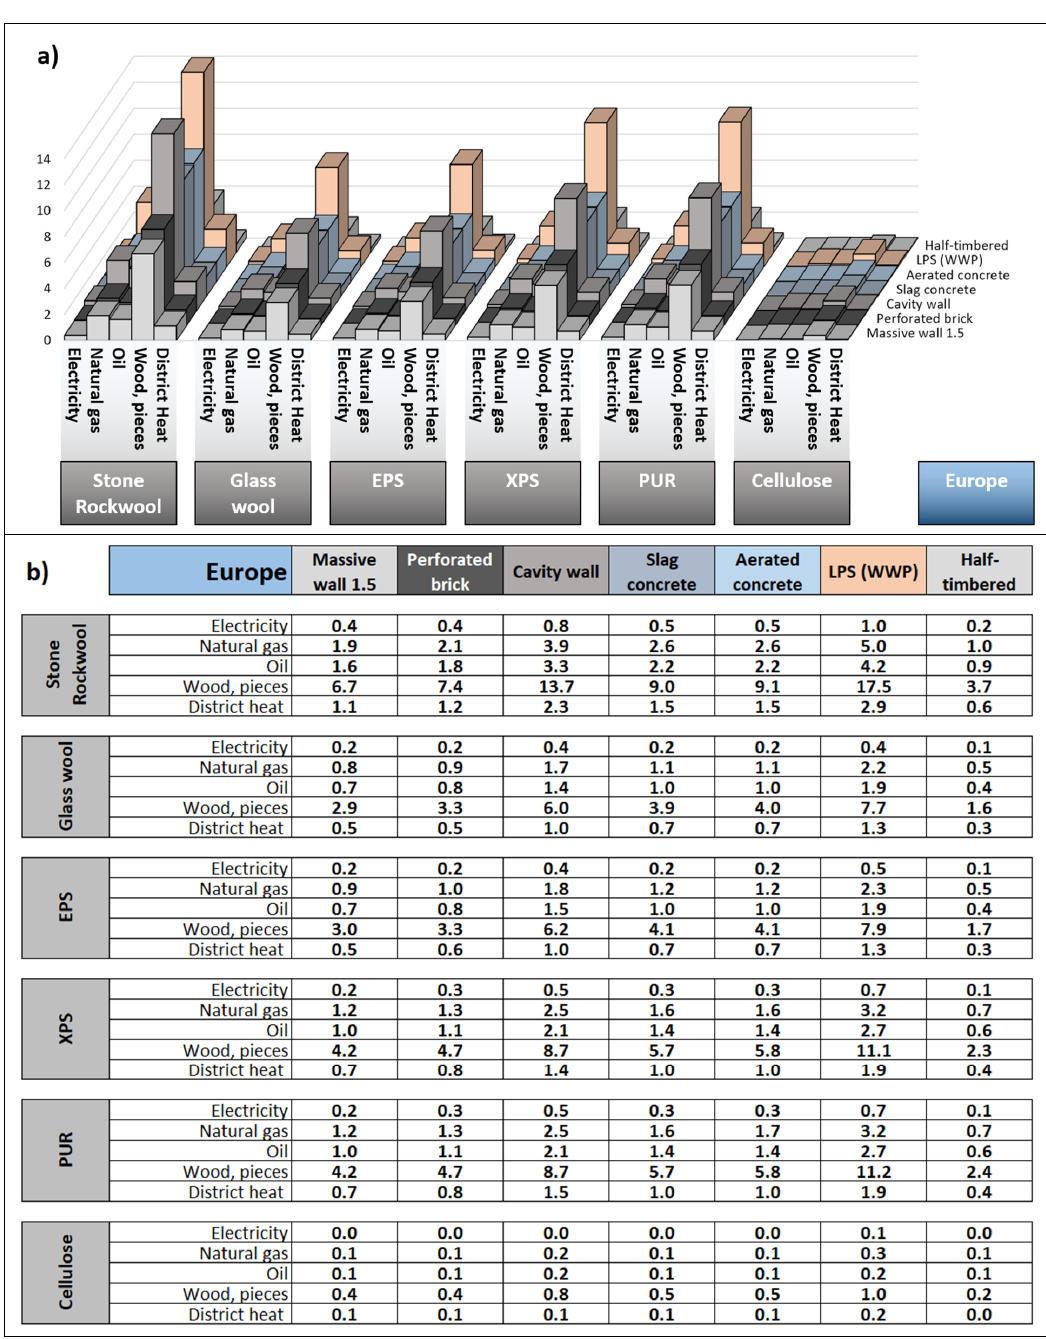
Figure 4. ( a ) CPP values chart for Europe . ( b ) CPP values for Europe. After averaging the data available from the EPDs available for the region of Europe, PEFn values for Europe, emission factors and climatic conditions for Brussels, the longest CPP is for stone/rockwool insulated walls (up to 17.5 years for LPS (WWP) walls and 13.7 for Cavity wall). As in the case of Europe (aver.), the highest CPP values can be found in the existing partitions with the greatest resistance, for spaces heated with biomass and for